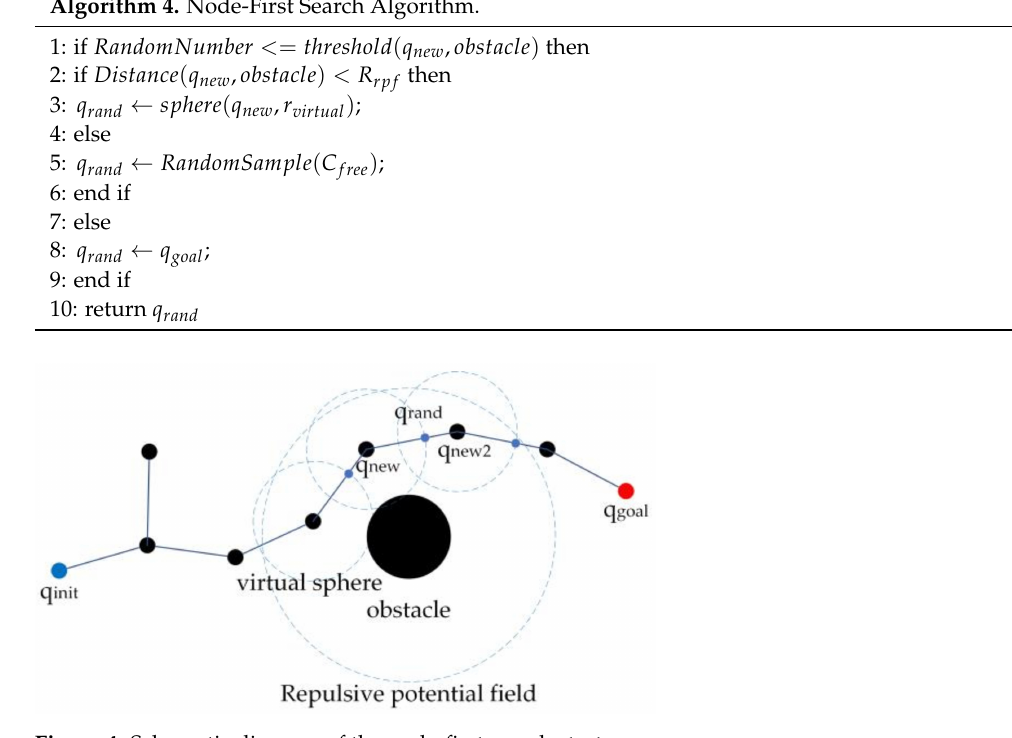
Figure 4. Schematic diagram of the node-first search